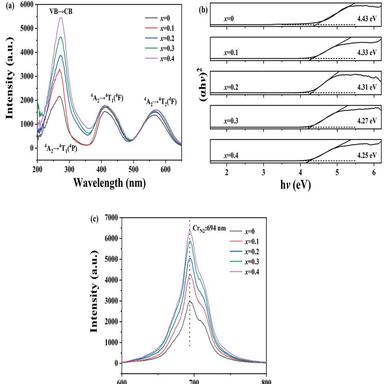
(a) PLE spectra of ZGSO:Cr3+ (x = 0-0.4) and (b) The bandgap energies of ZGSO (x = 0-0.4). (c) PL spectra of ZGSO:Cr3+ (x = 0-0.4) under the excitation of 270 nm.